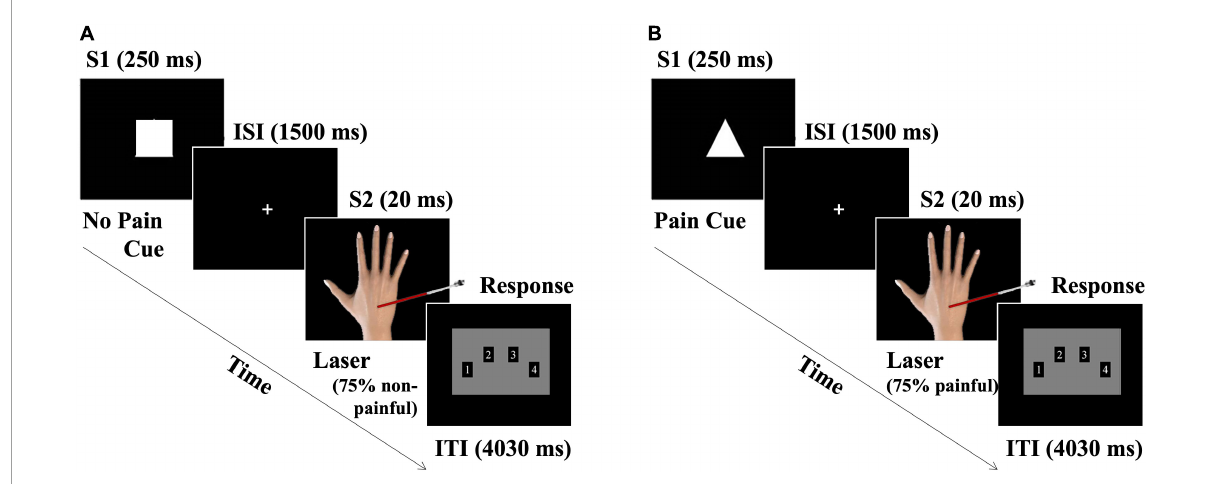
FIGURE1 Schematic representation of the experimental procedure. The S1–S2 paradigm is displayed, where S1 = cue (visual) correctly predicted the intensity of the upcoming S2 = target (laser stimulation) in 75% of the trials. (A) No Pain cue trial, and (B) pain cue trial representations. The interstimulus interval (ISI) was 1,500 ms. Intertrial interval (ITI) = 4,030 ms. Only responses within the first 2,000 ms of ITI were